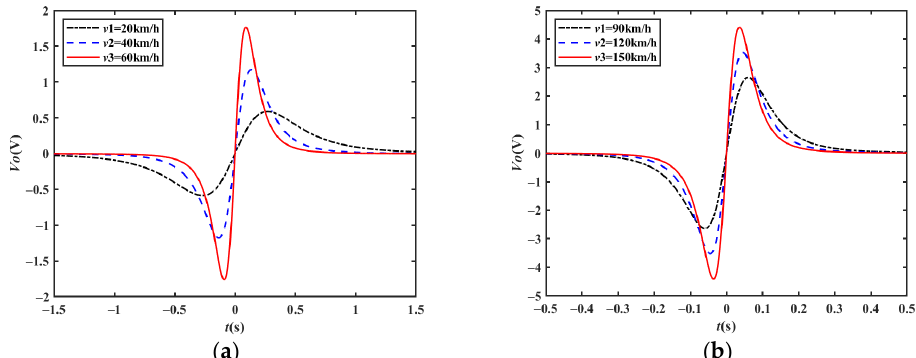
Figure 4. Simulation output waveforms at different velocities: ( a ) velocity at 20 km/h, 40 km/h, and 60 km/h; ( b ) velocity at 90 km/h, 120 km/h, and 150 km/h. When the distance z’ between the detection electrode and the driving direction changes, the output waveform for the moving target velocity v = 40 km/h is as shown in Figure 5, where the waveform amplitude decreases, and the waveform width does not change much, with the peak coordinates slightly delayed.